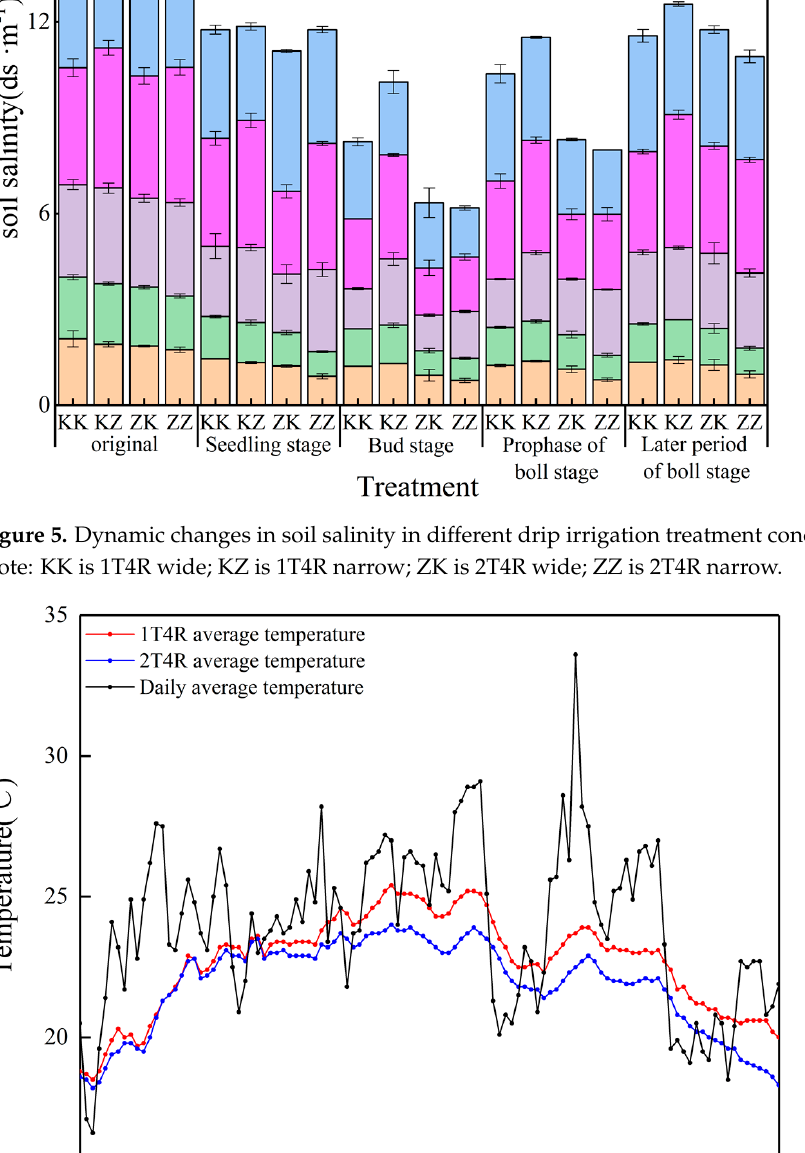
Figure 5. Dynamic changes in soil salinity in different drip irrigation treatment conditions in 2018a.